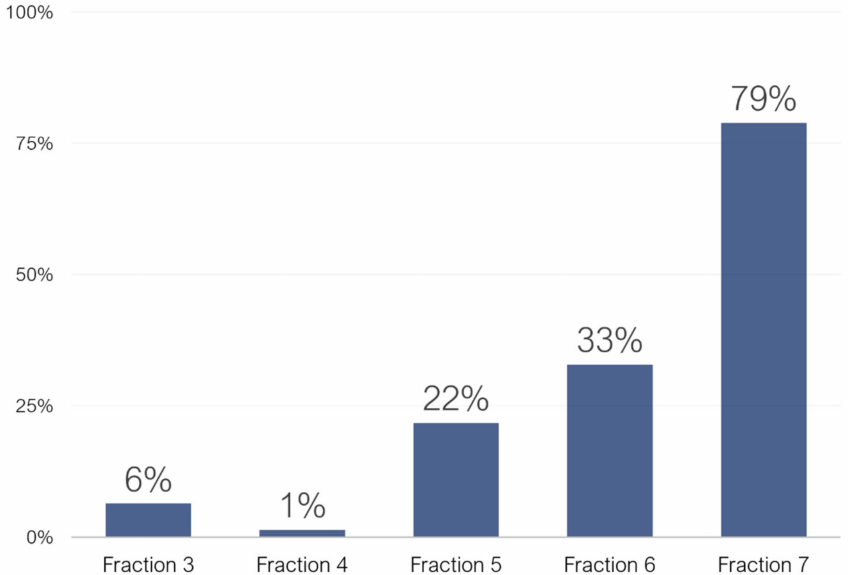
Figure 2. Bar chart displaying the peak areas (%) of non-phenolic compound with respect of the total peak area of tentatively identified compounds in fractions